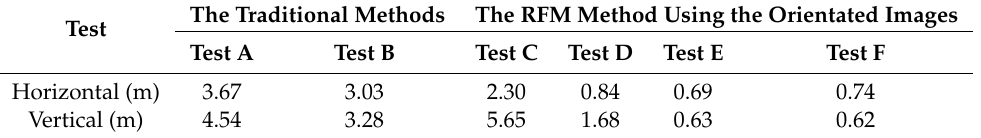
Table 7. Accuracies for IKONOS-Scene05 and IKONOS-Scene06 with traditional methods and the RFM method.